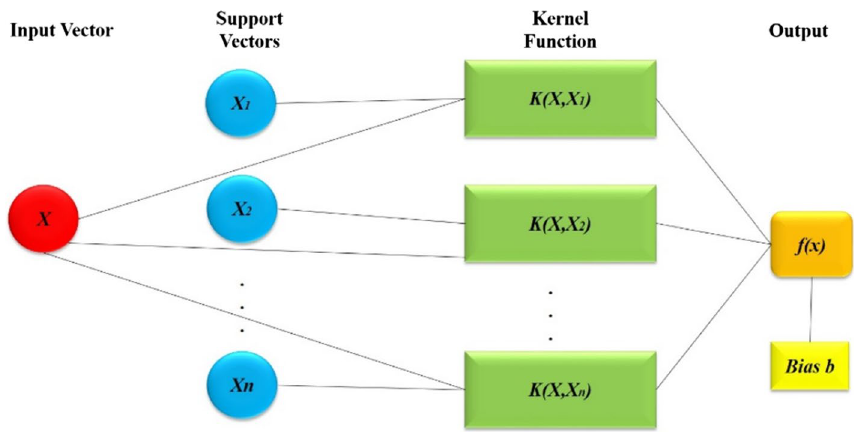
Fig. 3 Simple composition of